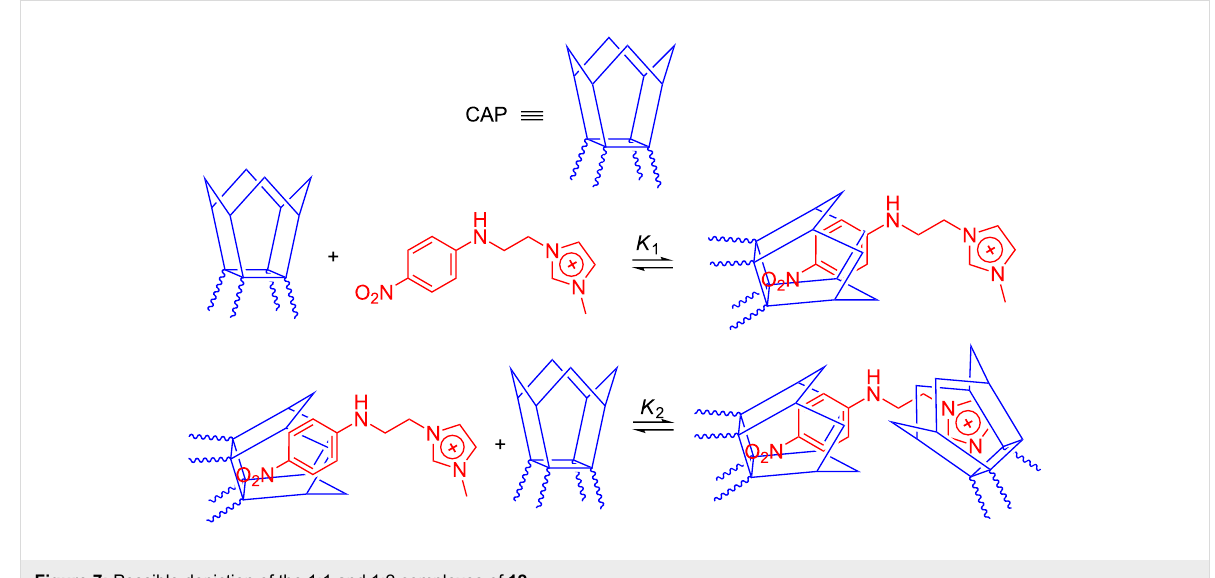
Figure 7: Possible depiction of the 1:1 and 1:2 complexes of 12 .